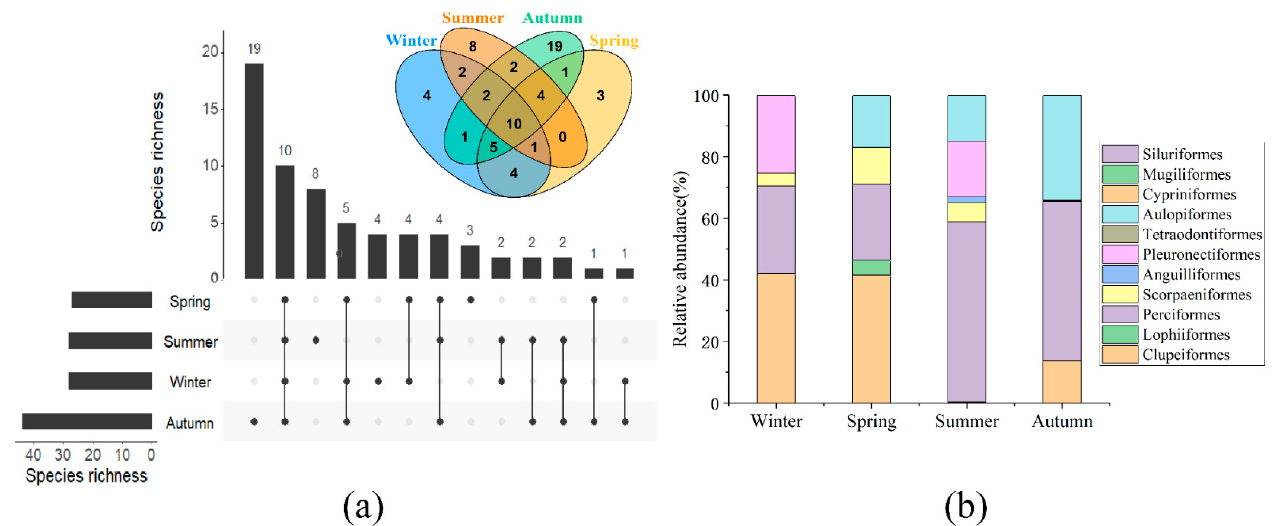
Figure 5. Species richness ( a ) and relative abundance of taxa ( b ) in the Yangtze Estuary and adjacent waters from 2018. ( a , lower): UpSet plot showing the fish composition from 2018 (e.g., 19 species were found only in autumn (left), whereas 10 species occurred each season).